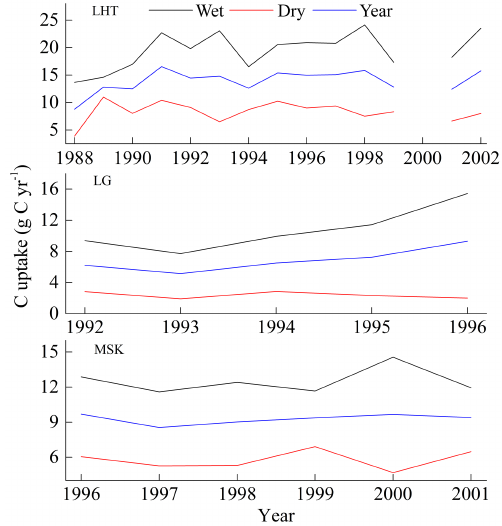
Figure 7. Variation in bicarbonate ion concentrations among sites in the wet season, dry season, and whole year during the study period.